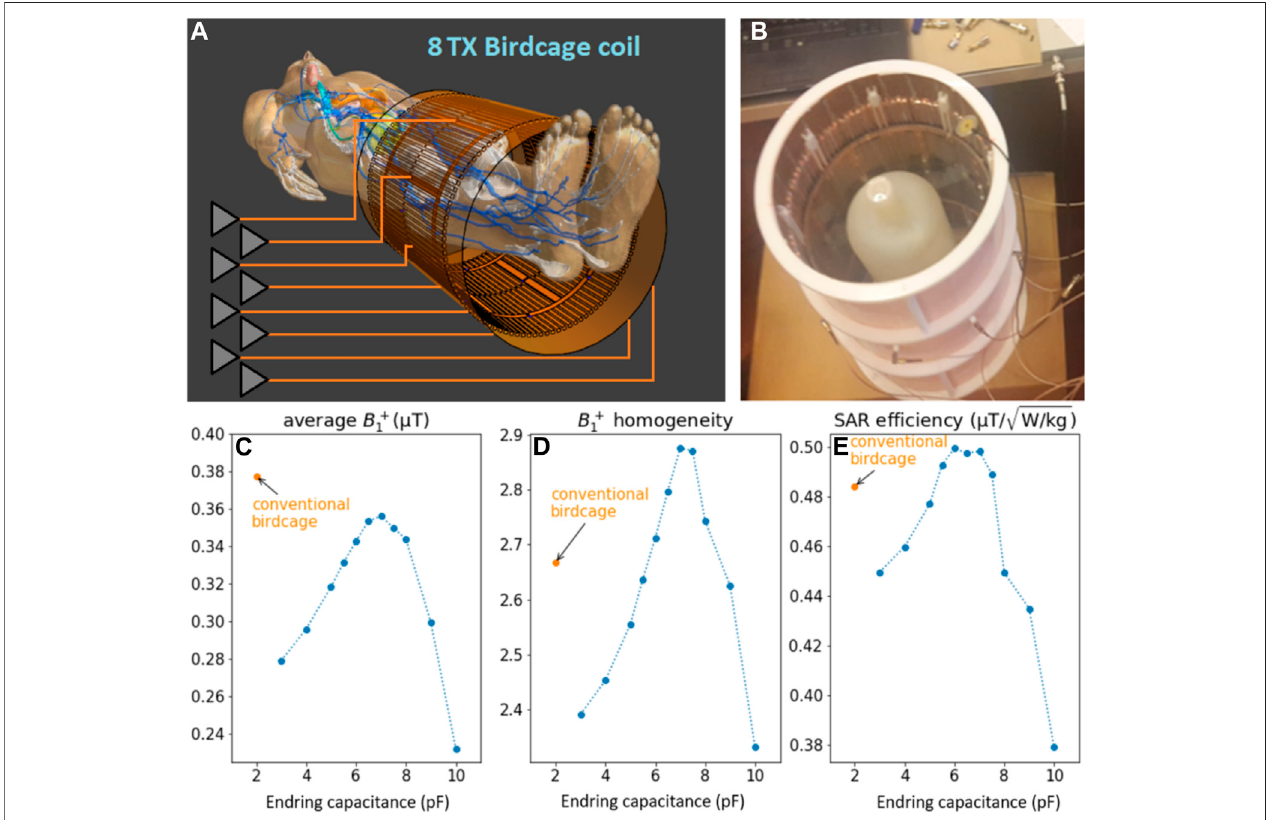
FIGURE9|(A) 8Txbirdcagecoil withSRSinFDTDsimulation environment (Sim4Life) withafeedingport located ineachrung. (B) photograph ofthe8Txbirdcage coil with SRS and a loading phantom. The ports are connected through small holes in the shield. (C – E) “ Tuning ” the 8Tx birdcage. Simulated (at 300 MHz) values of average B 1+ (C) , homogeneity (D) and SAR ef fi ciency (E) are shown as a function of endring capacitance value. Values obtained with a conventional birdcage (with the same dimensions as the 8Tx birdcage) are also shown for reference. All results are normalized to 1 W accepted